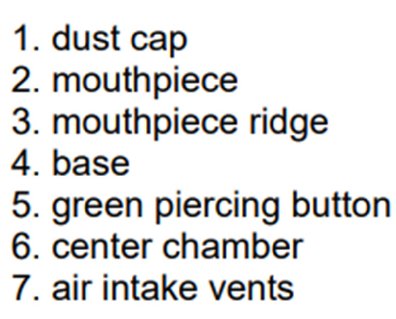
Figure 1. Diagram of the Spiriva HandiHaler [27].